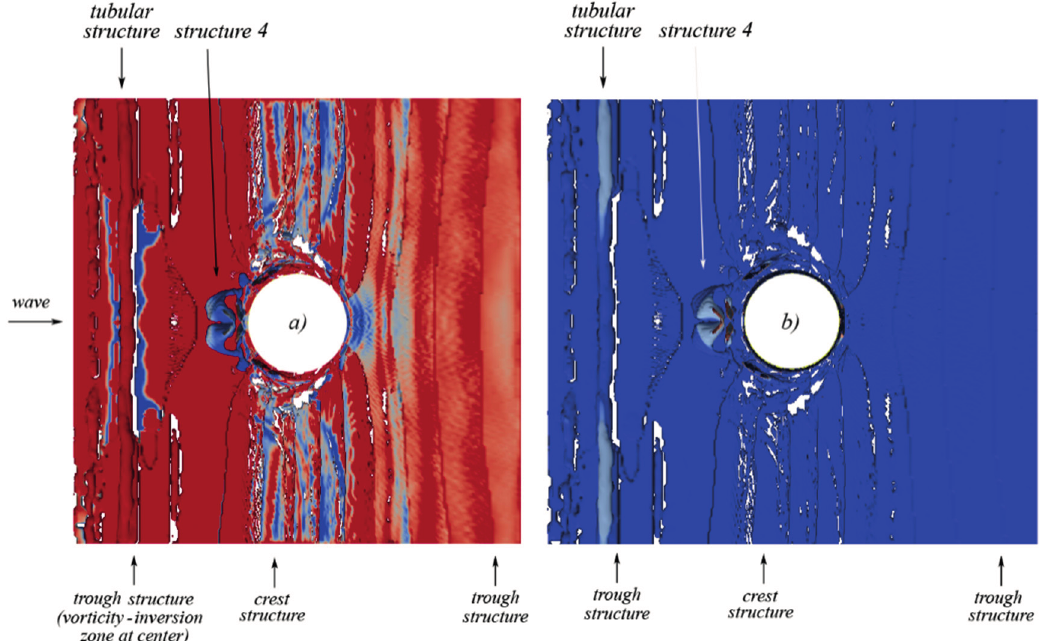
Figure 22. Close-up views of structures as obtained from the solution of the Navier-Stokes equations. Bottom view of computing domain at structures are colored with: ( a ) wave-field spanwise vorticity; ( b ) wave-field pressure values.